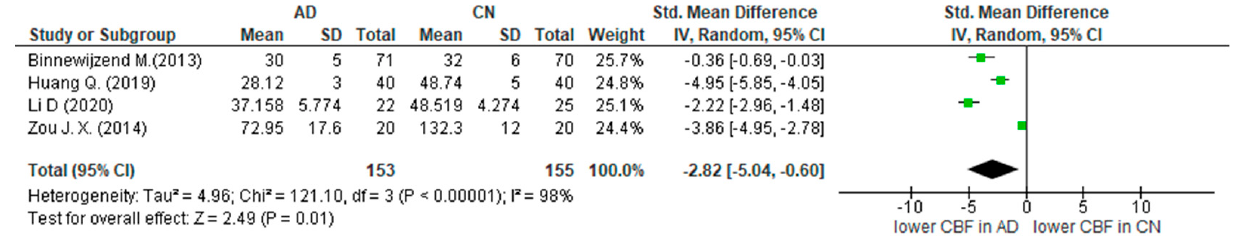
Figure 4. Hippocampus: mild cognitive impairment vs. cognitively normal (Alexopoulos P. (2012) [33], Dai W. (2009) [41], Dolui S (2020). [43], Glodzik L. (2011) [45], Huang Q. (2019) [47], Li D. (2020) [50], Westerberg C. (2013) [55], Wierenga C.E. (2012) [56]). There is no statistical difference in cerebral perfusion between MCI and CN.